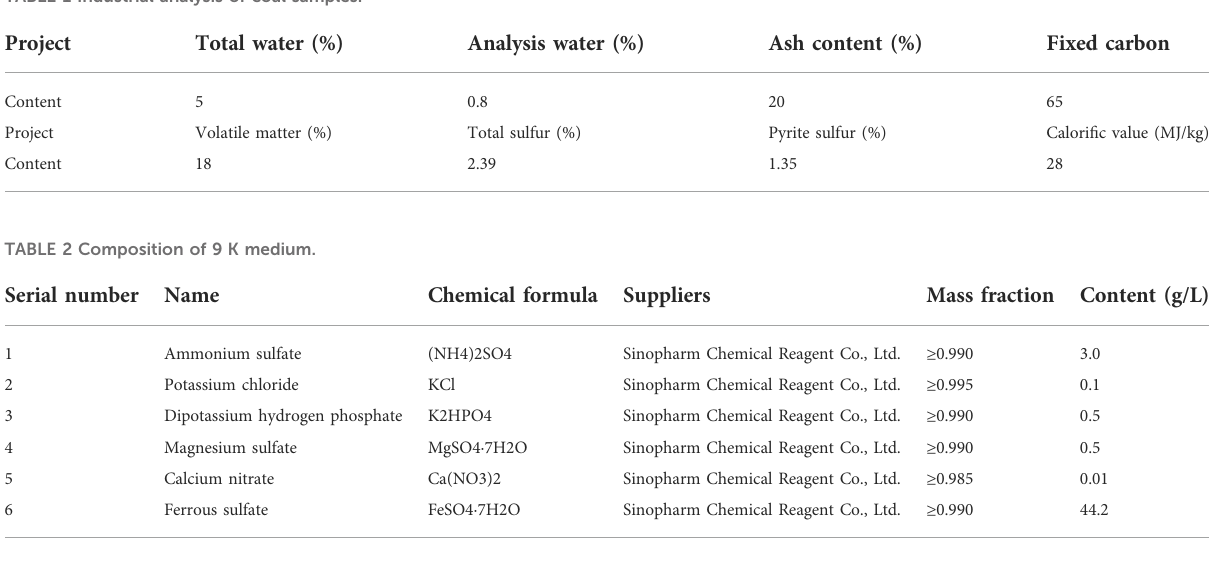
TABLE 1 Industrial analysis of coal samples.